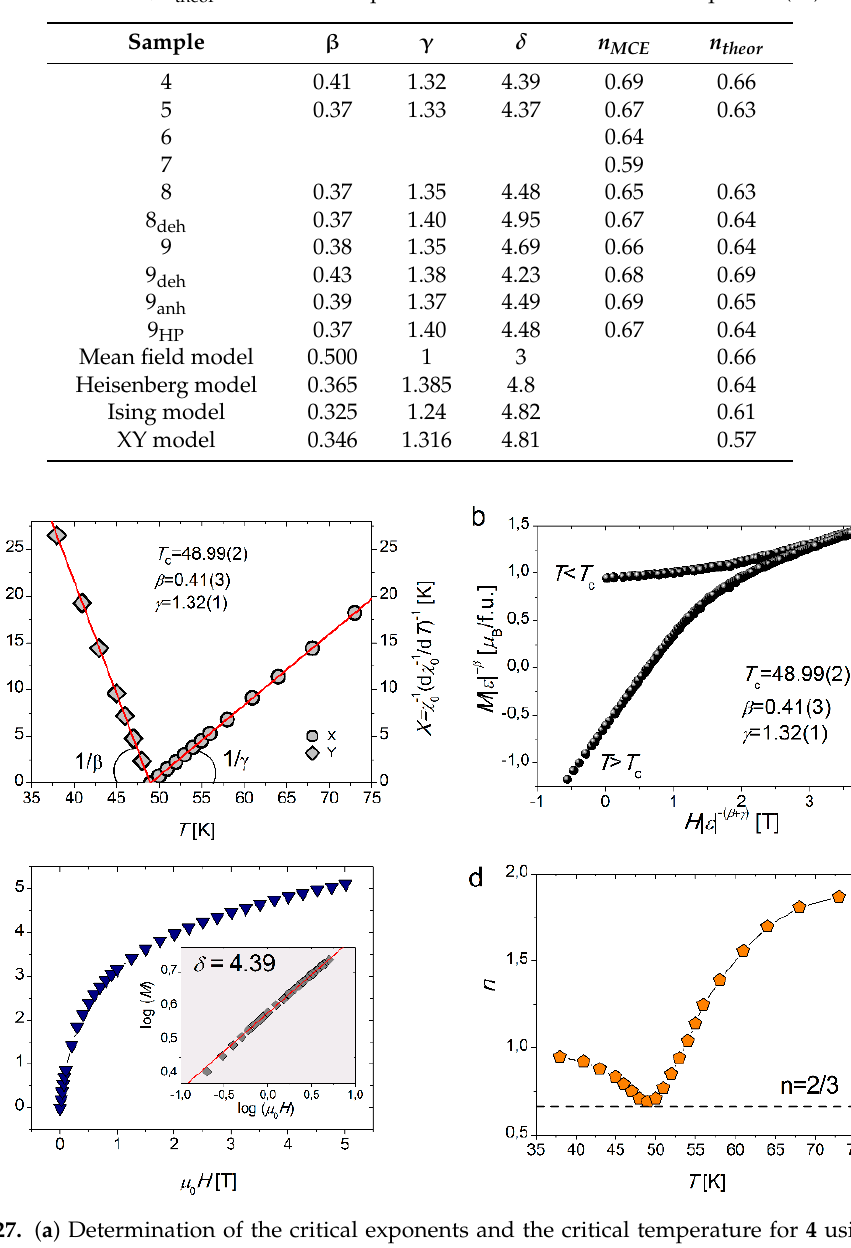
Table 5. Comparison of the critical exponents determined for samples discussed in Section 3 and for the mean field and 3D Heisenberg, 3D Ising, and 3D XY model. n MCE —the critical exponent n determined based on the MCE data , n theor —the critical exponents n determined based on Equation (13).